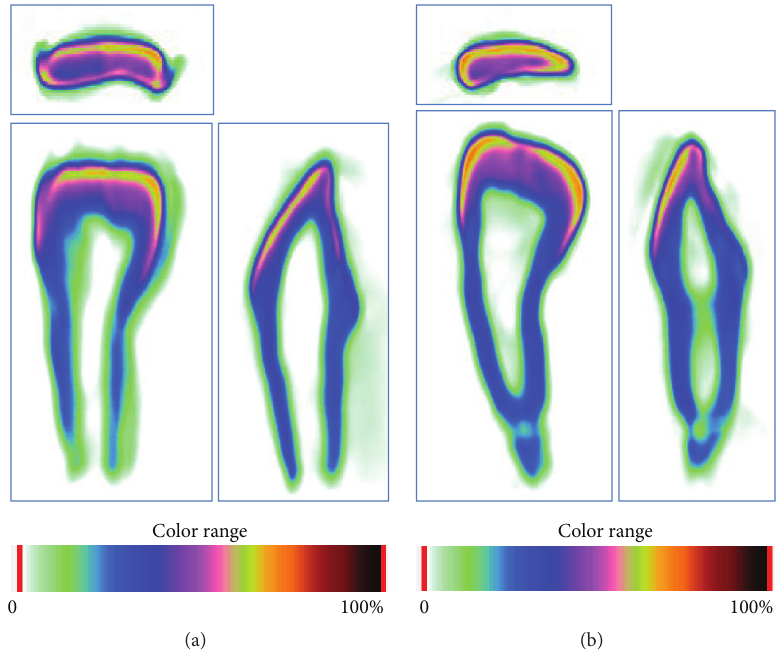
Figure 5: Mineral density mapping of incisal, labial, and mesial views in HPP and on (a) mandibular primary left central incisor (71) and (b) mandibular primary left lateral incisor (82). Color range represents the relative values of attenuation coefficient. Here, 100% is equal to 3.0 g/cm 3